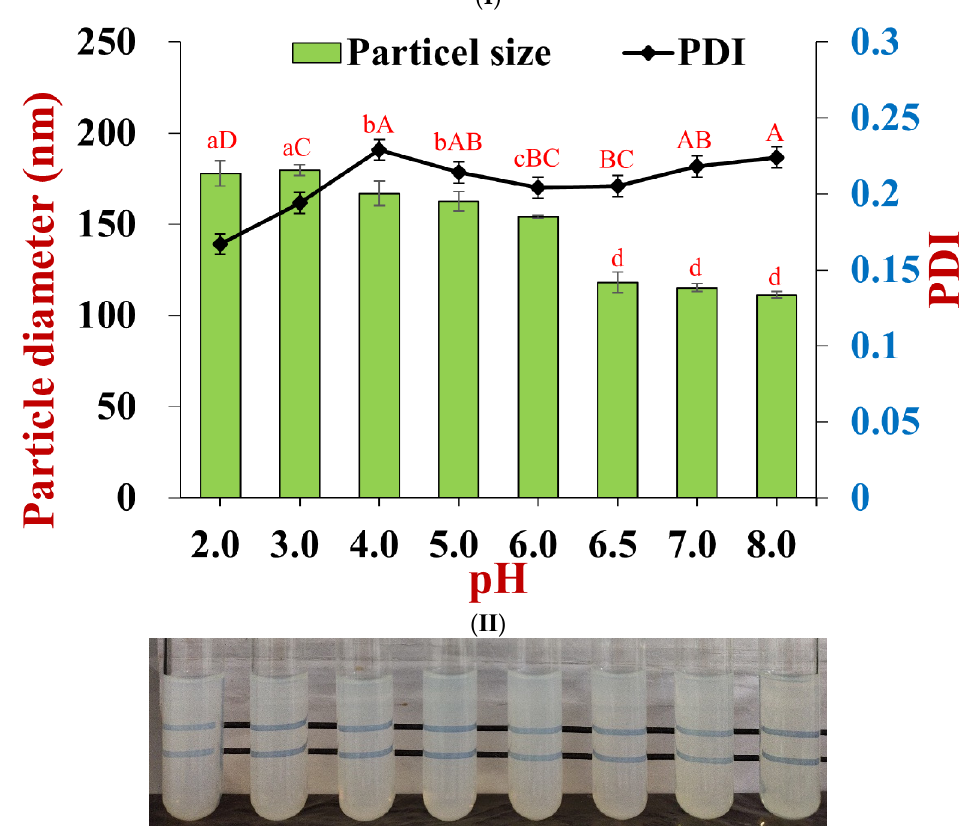
Figure 3. Effect of pH on the stabilities of nanoparticles co-loaded with tannic acid and resveratrol. ( I ) Particle diameter and PDI at different pH (lowercase statistic notation—particle size; capital statistic notation—PDI, p < 0.05); ( II ) the appearance of particles at pH values ranging from 2.0 to 8.0.